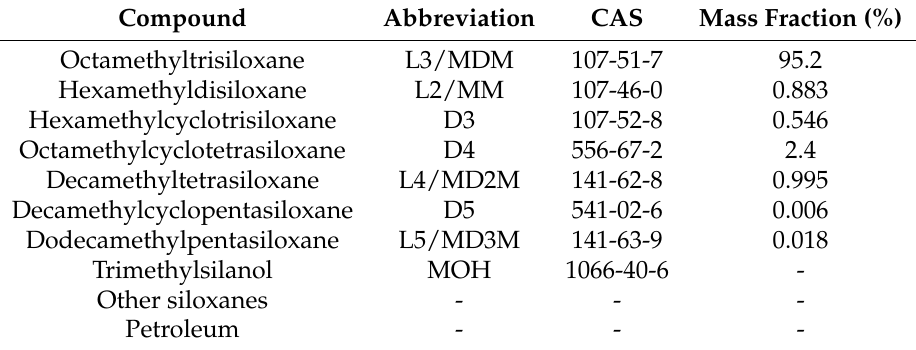
Table 7. HS-GC-MS analysis results of Experiment A, Product #2.